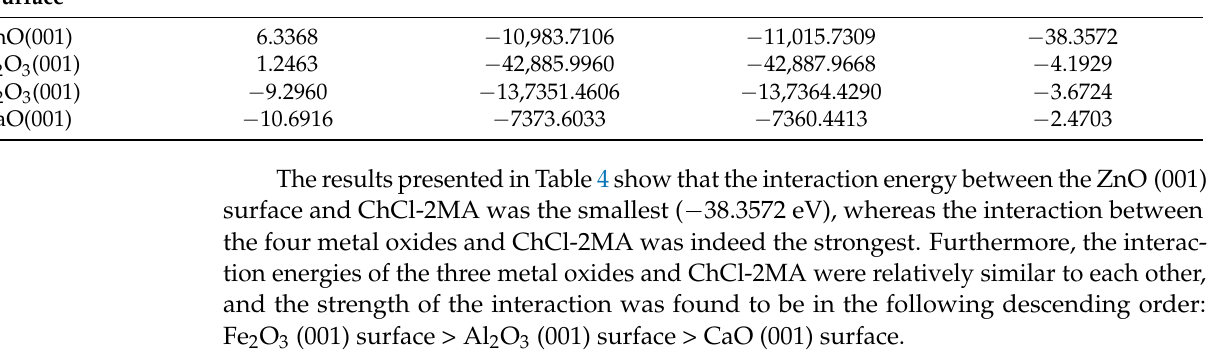
Table 4. Interaction energies between the complete-cleavage surfaces of the metal oxides and ChCl-2MA (/eV).